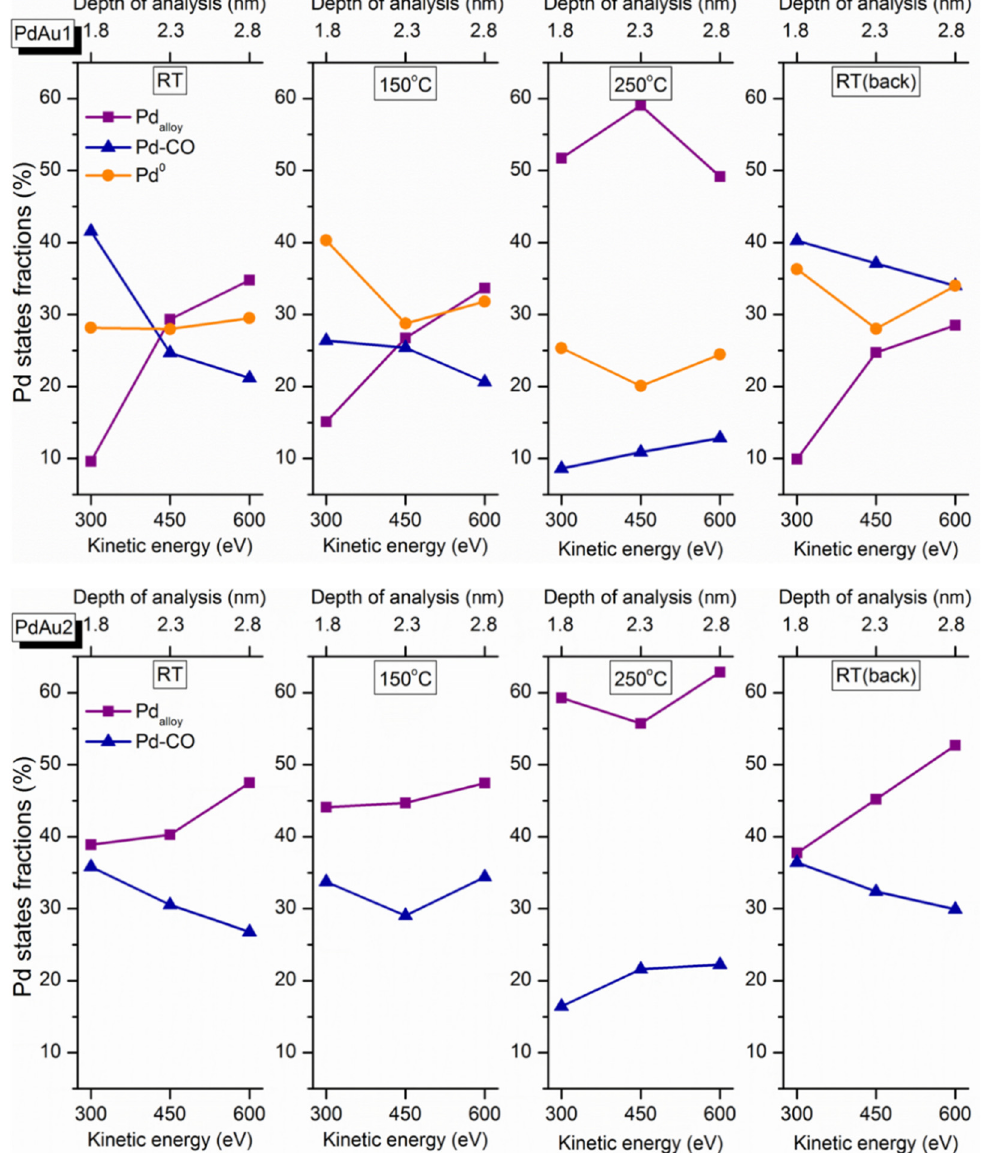
Figure 6. Depth profiles of fractions corresponding to distinct Pd states for different temperatures for PdAu-1 ( upper panels ) and PdAu-2 ( bottom panels ).